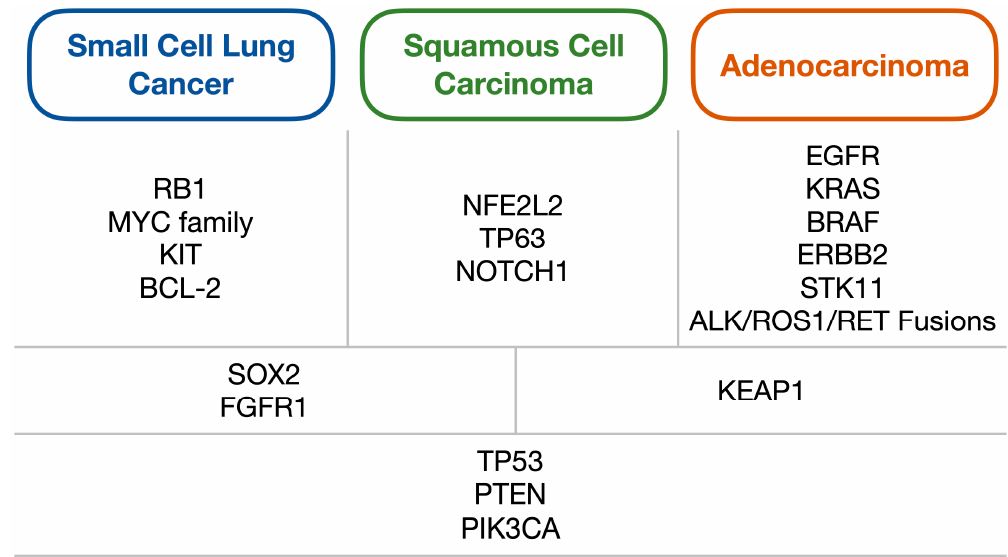
Figure 1. Diagram of the common genetic alterations found within lung carcinomas, split into alterations generally associated with either small cell lung cancer, squamous cell carcinoma or adenocarcinoma (first row); those commonly shared between two of the three subtypes (second row); and alterations shared between all three (third row). Adapted from Pietanza and Ladanyi (2012) [21].